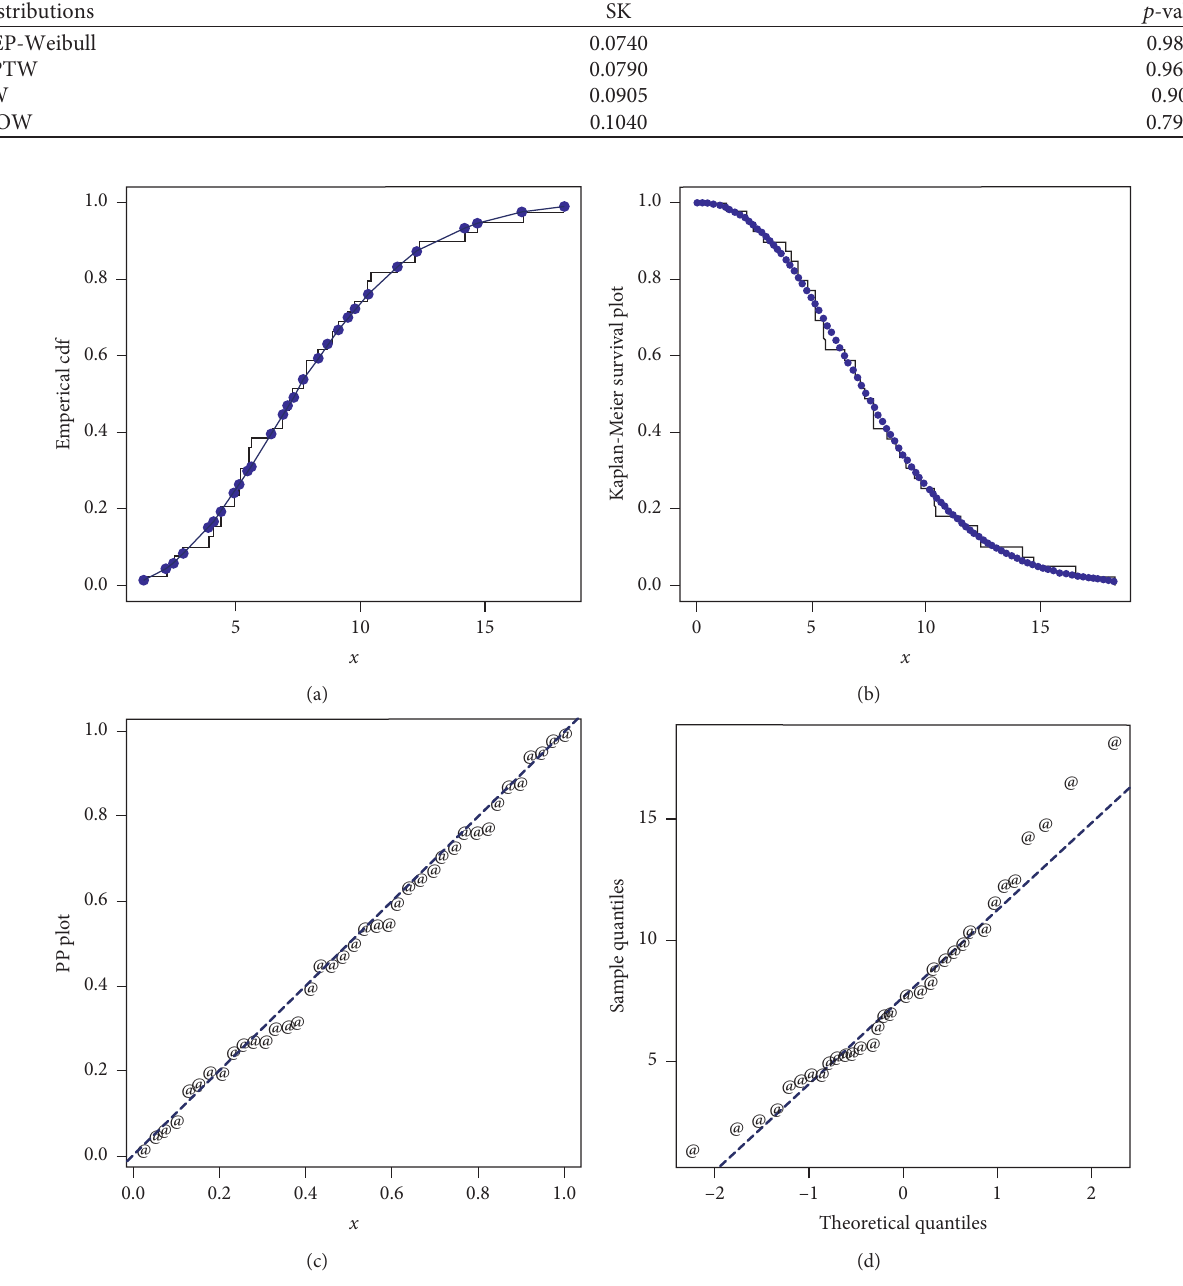
Table 4: The KS and p -value of the fitted models to the life span of the WSNs data. Distributions